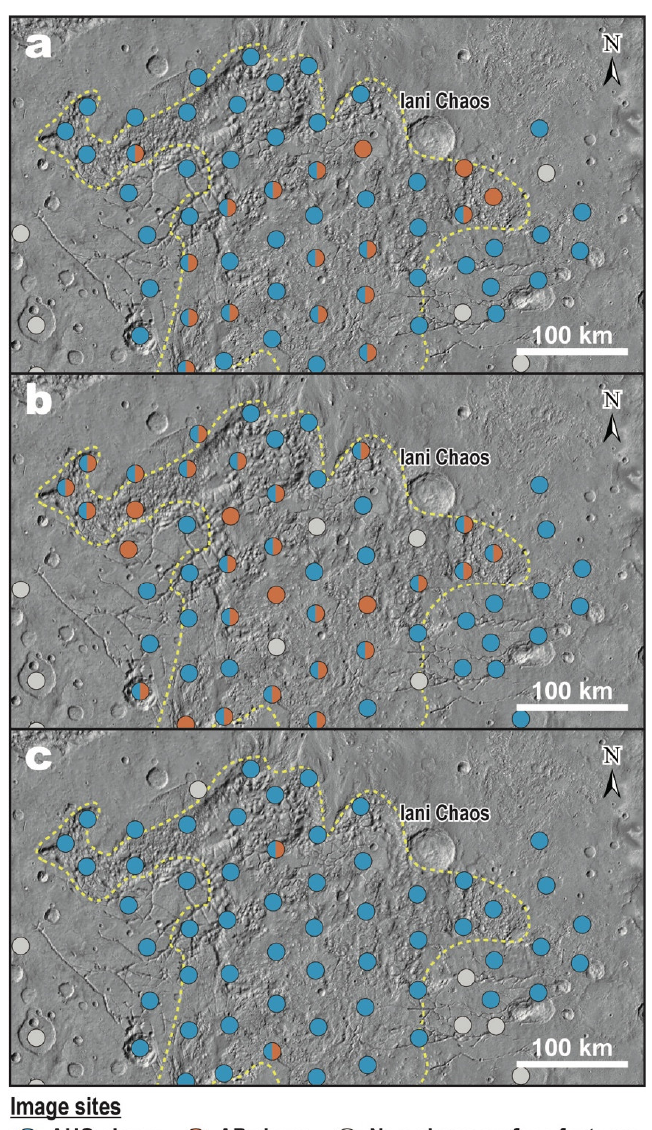
Figure 10. Classification results of chaos blocks (locations shown by circles) for Iani Chaos: ( a ) CTX classifier; ( b ) THEMIS classifier; ( c ) MOLA classifier. Circle colors indicate the classification result. Circles showing both blue and orange reflect our suggestion that the probabilities of AHO and AP chaos blocks are approximately equal. Regions surrounded by yellow dotted lines are chaos-like features.